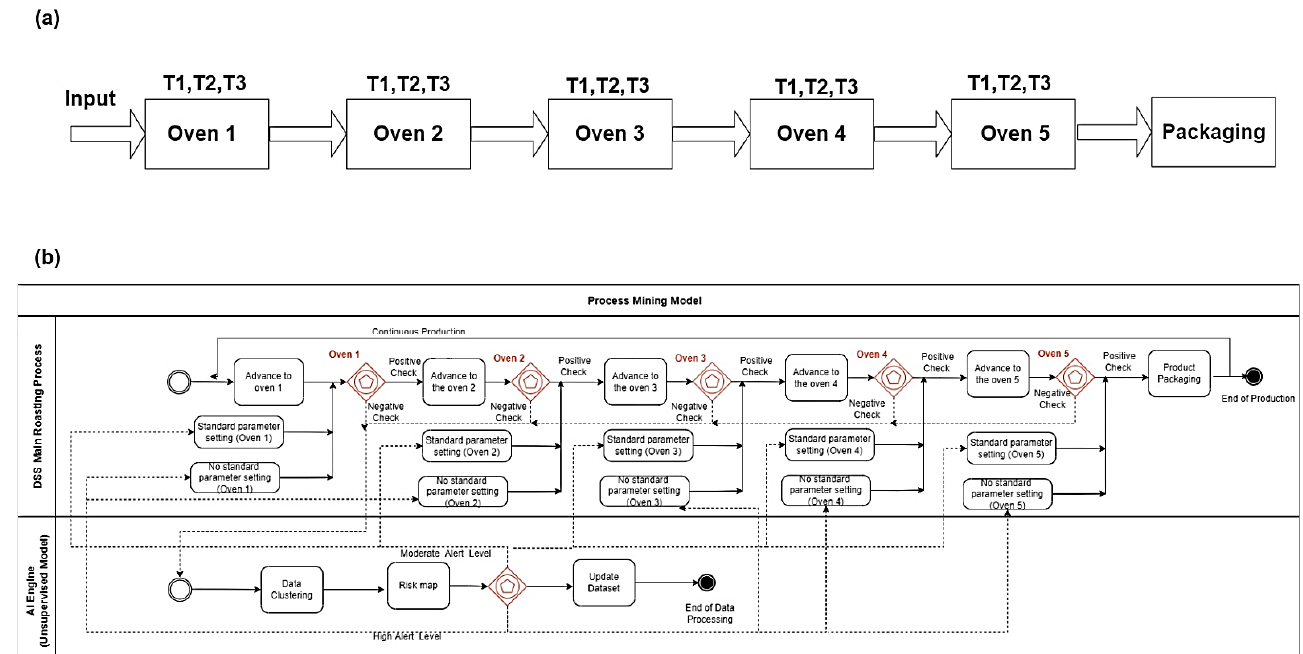
Figure 6. ( a ) Basic scheme of the roasting production process concerning the passage of the product into five ovens, where each oven is monitored by three temperature sensors providing parameters T1, T2 and T3. ( b ) The BPMN PM model representing the automatic setting of oven temperatures by means of an AI unsupervised engine (application of k-Means algorithm).